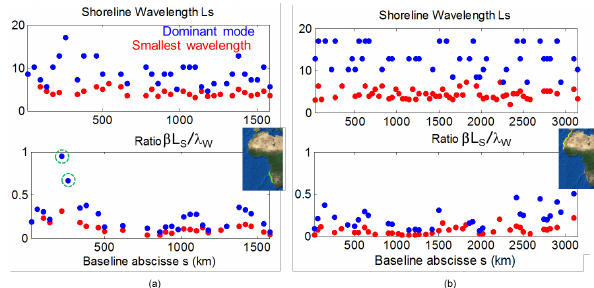
Fig. 5. Shoreline wavelength and computed ratio for (a) the South (red area) and (b) North part (yellow area) of the Atlantic coast of Figure 5. Shoreline wavelength and computed ratio for (a) the South (red area) and North part 4 (yellow area) of the Atlantic coast of Africa. 5